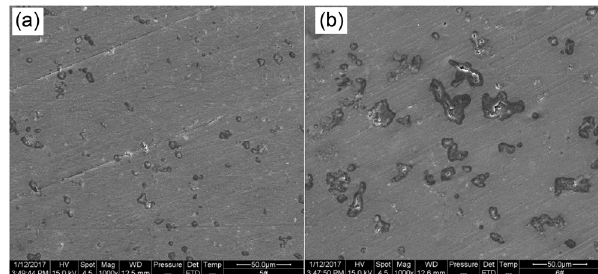
Fig. 32 SEM micrograph of composites with BP content of (a) 15 wt%; (b) 20 wt%.